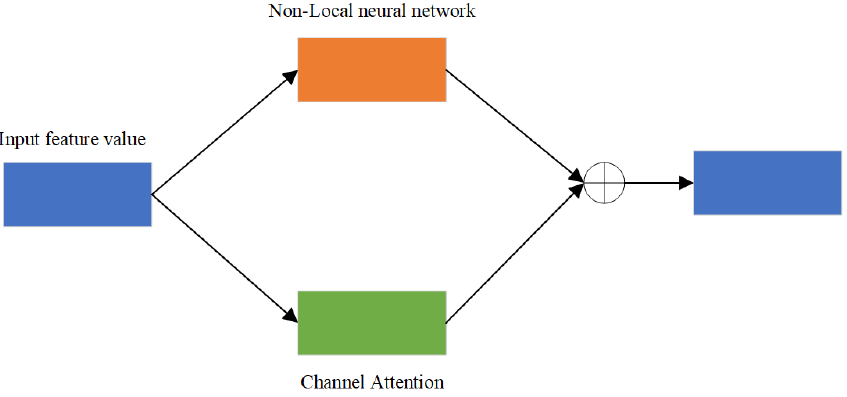
Figure 2. Dual Self-a tt ention Module (DSAM).